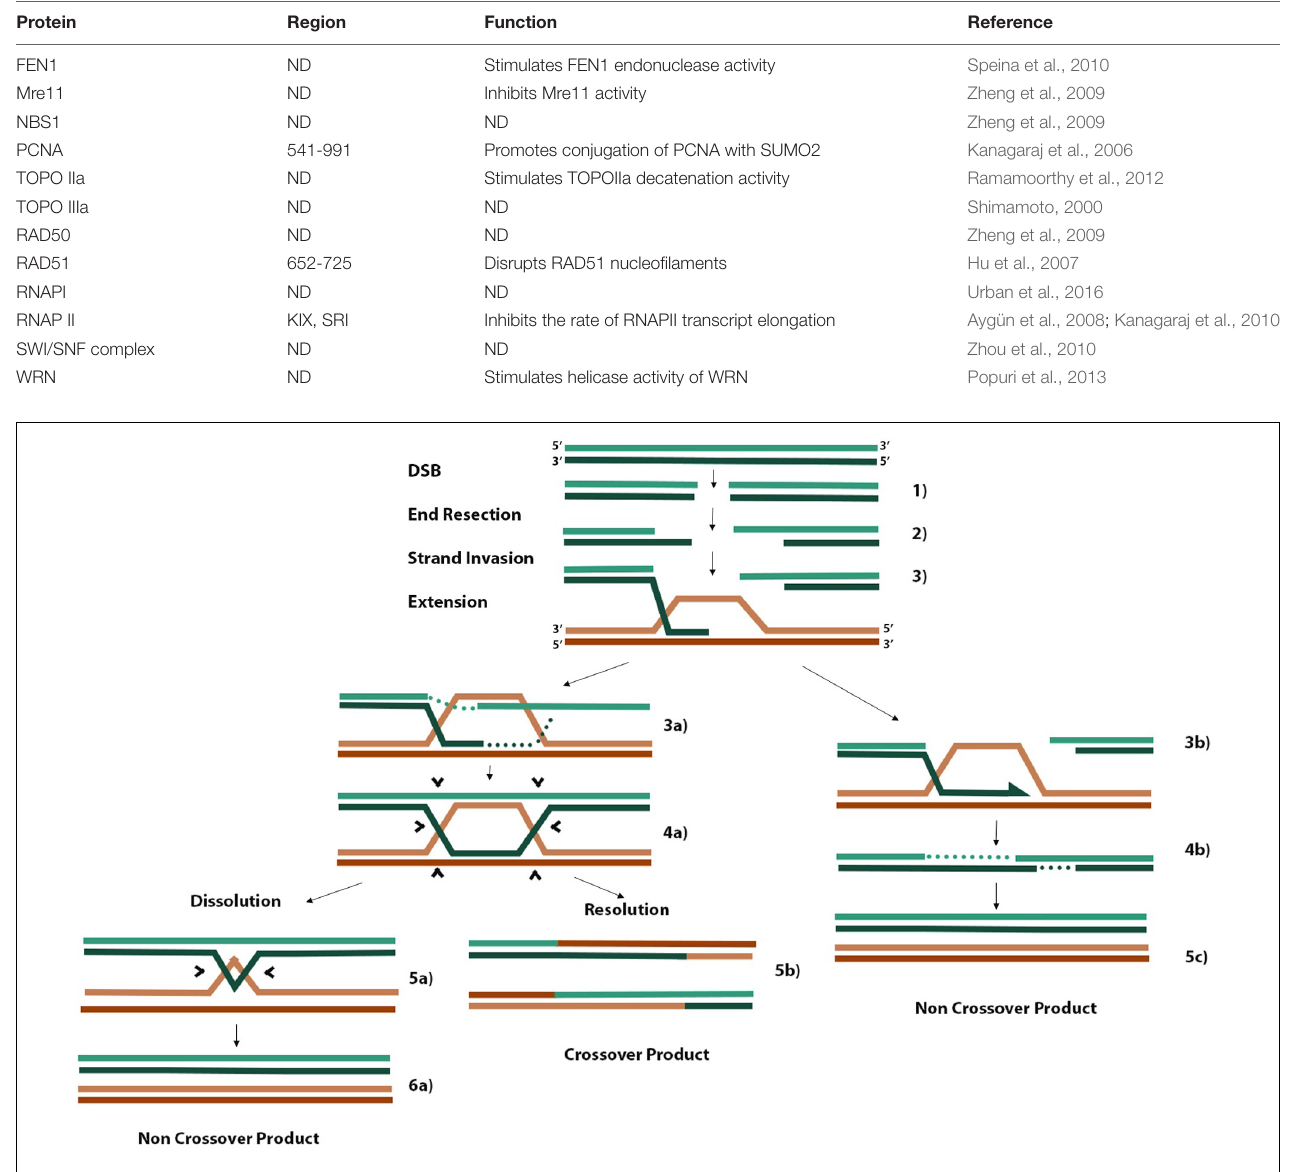
FIGURE 2 | Homologous recombination schematic of different repair pathways. Three initial steps that are common to all pathways include end resection of 3 (cid:48) overhangs, strand invasion of one or both overhangs with homologous donor DNA, and extension of annealed overhang (steps 1–3) . When only one resected end of the DSB performs invasion, a D-loop is formed, and extension proceeds by synthesis-dependent strand annealing where one overhang is extended until there is sufficient homology to hybridize with the other resected end, gaps are filled in, and nCOs are produced (steps 3b, 4b, 5c) . When the second resected end also hybridizes to the available strand in a D-loop, a dHJ is formed (steps 3a, 4a) . Processing of dHJs can proceed by promoting convergent migration of the structure until a small hemicatenane structure is formed (step 5a) , which can be cleaved by topoisomerases into an nCO product (step 6a) . Alternatively, asymmetric cleavage of the dHJ by non-specific resolvases can result in a CO product (step 5b) . The information from this figure was extracted from the works of Smith et al. (2007); West et al. (2016), and Rickman and Smogorzewska